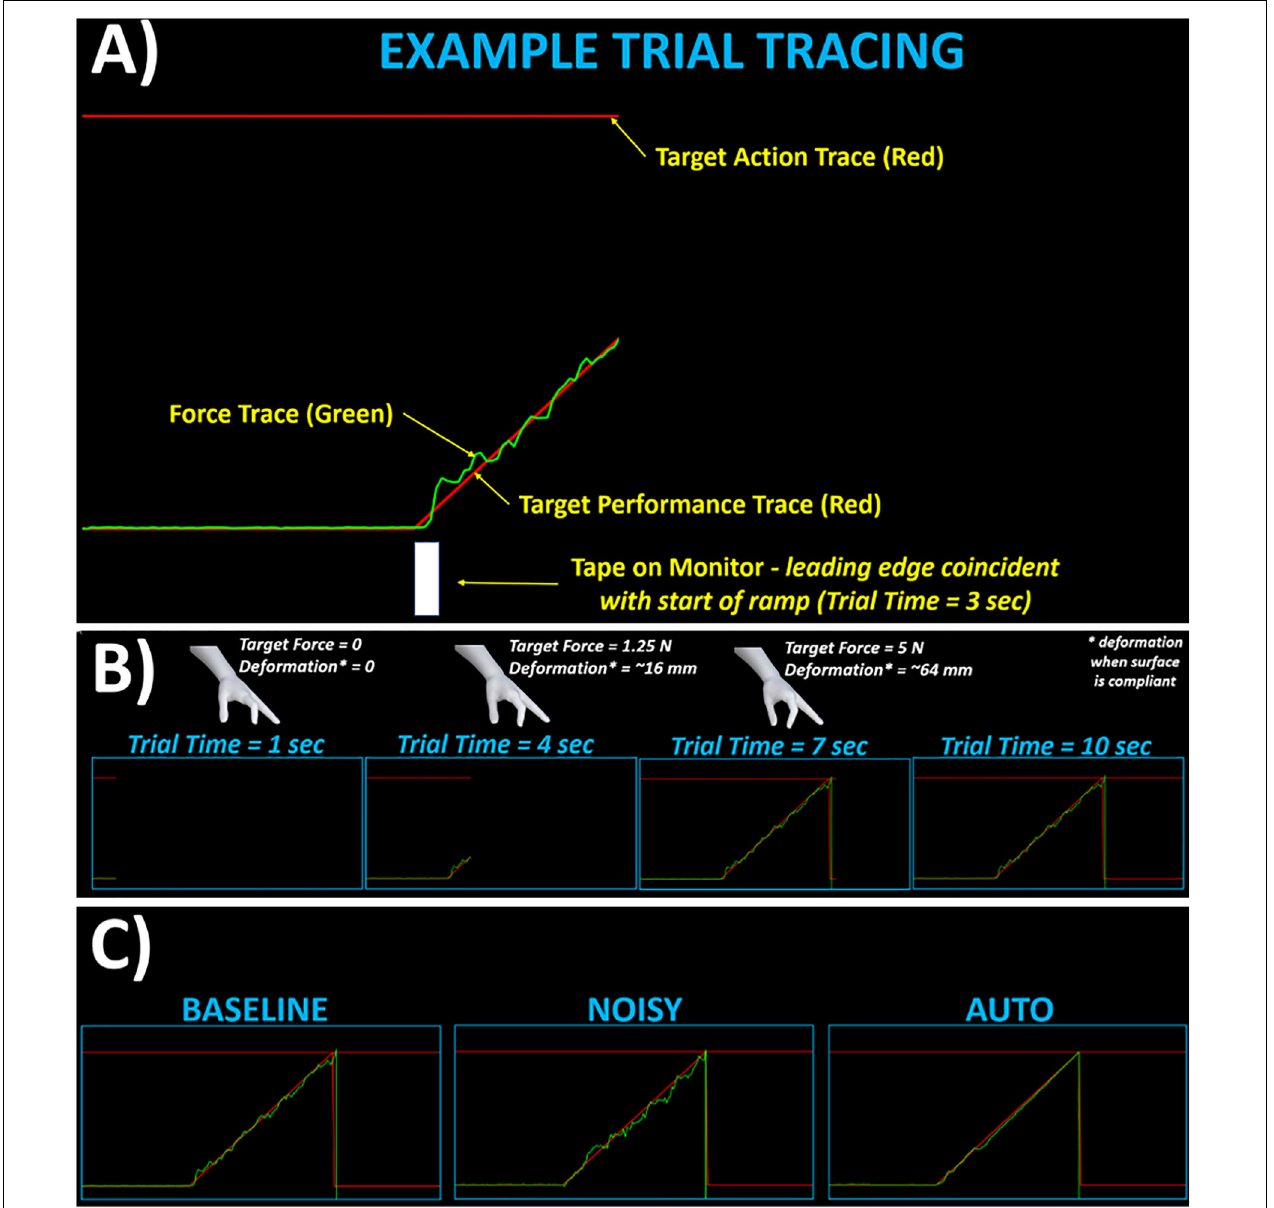
FIGURE 3 | Snapshots of real-time tracings shown for various trial cases. (A) Example depiction of force and target (action, performance) traces shown during ramp portion of trial. (B) Tracing shown at various progressive instances across the 10-s trial. Also shown are depictions of respective grasp postures and force-deformation moduli assuming a “compliant” grasp surface. (C) Representative final traces shown for trials with “Baseline”, “Noisy”, and “Auto” control modes.